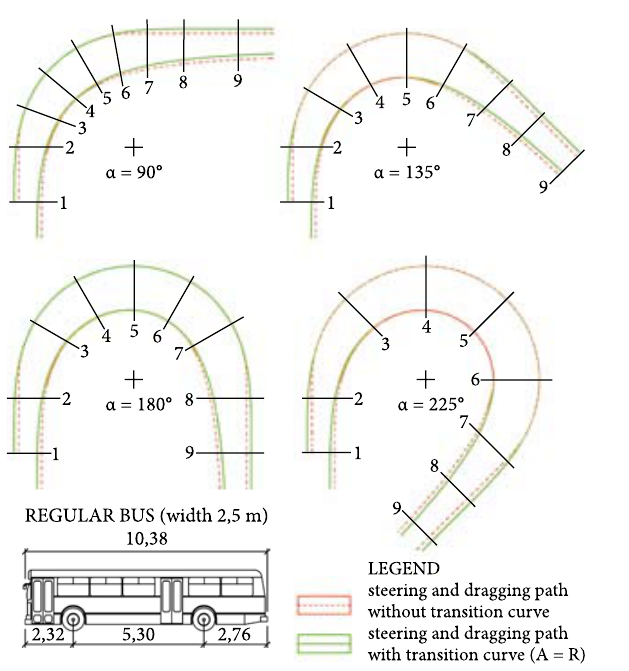
Table 1. Difference in traffic lane width with and without transition curve for curve radii R = 12,5 m Cross- section